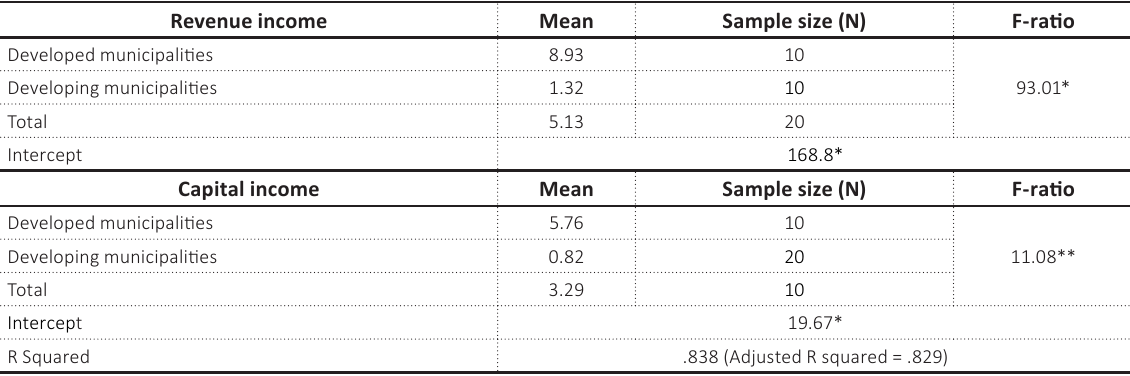
Table 7. Revenue and capital income of developed and developing municipalities